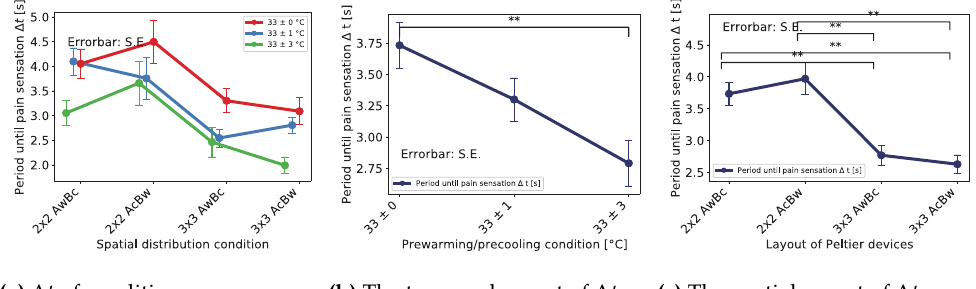
Figure 7. ∆ t ’s results of spatial distribution effect (except the outlier). The ** indicates a significant difference of p < 0.01. ( a ) Effect of layout of Peltier device and pre-cooling/pre-warming condition on time until pain. ( b ) Averaged effect of pre-cooling/pre-warming condition on time until pain. ( c ) Averaged effect of layout of Peltier device on time until pain.